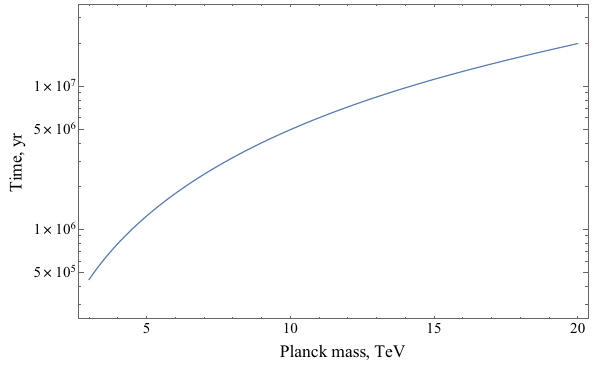
Fig. 1 Lower bound on the Earth accretion time in the theories with D = 6 dimensions and values of the Planck mass from 3 to 20